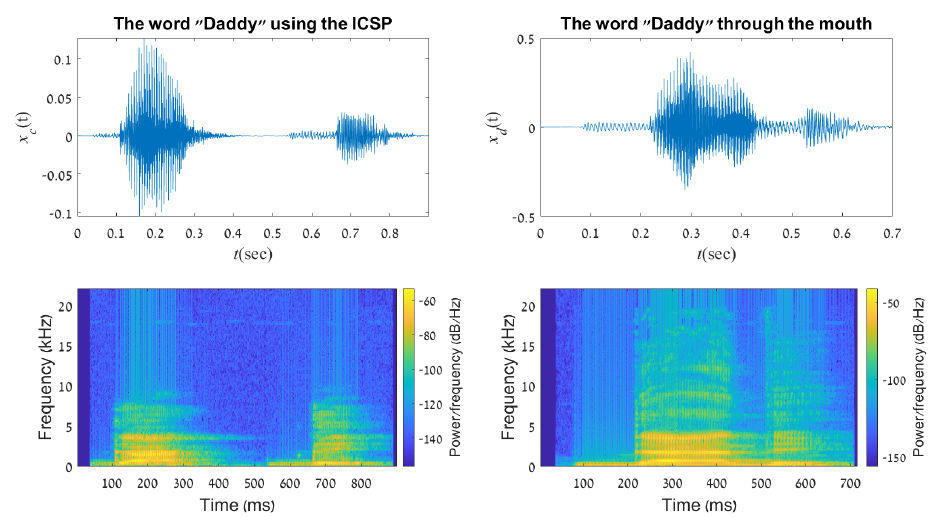
Figure 7. A representation of the word “Daddy” in time domain and frequency spectrogram, created using the ICSP ( left column ) and the human mouth ( right column ).